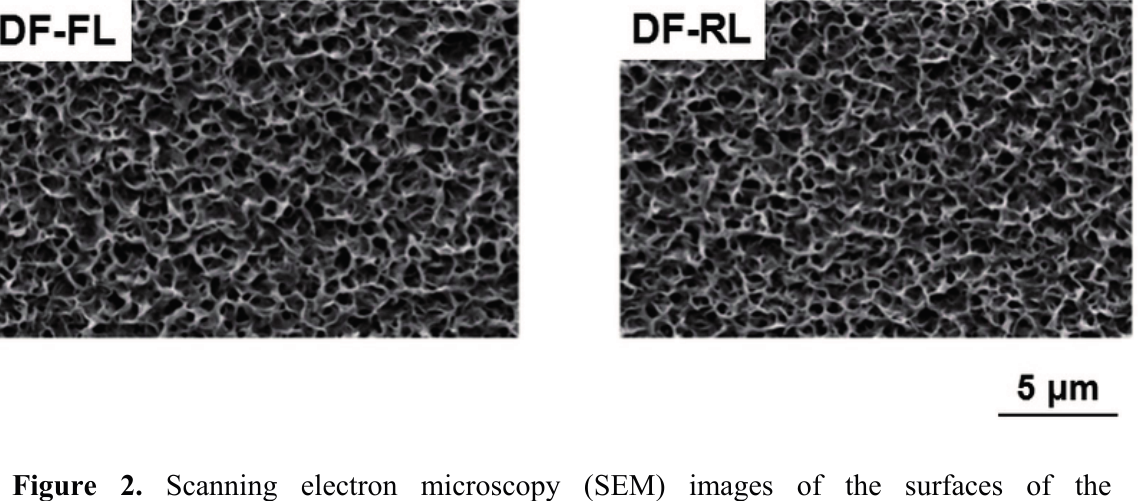
Figure 2. Scanning electron microscopy (SEM) images of the surfaces of the DNA–fibronectin–apatite composite layers (DF-Ap layers) immobilizing firefly luciferase ( FL ) gene (Sample DF-FL) and Renilla luciferase ( RL ) gene (Sample